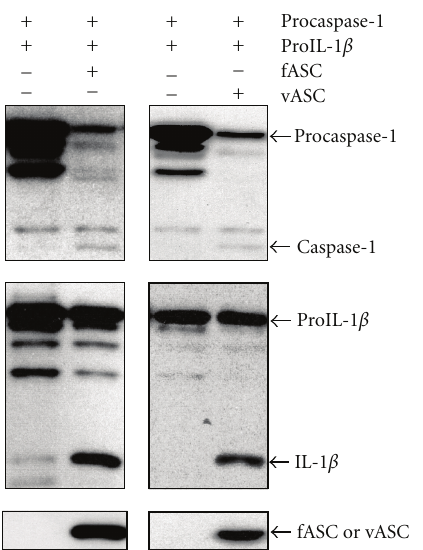
Figure 3: Comparison of caspase-1 and IL- β activation between fASC and vASC. Western blotting of coexpressed procaspase-1 and proIL-1 β with fASC or vASC in Cos7 cells. Procaspase-1: 45 kDa, caspase-1 (active form): 20kDa, proIL-1 β : 31 kDa, IL-1 β (active form): 17 kDa.